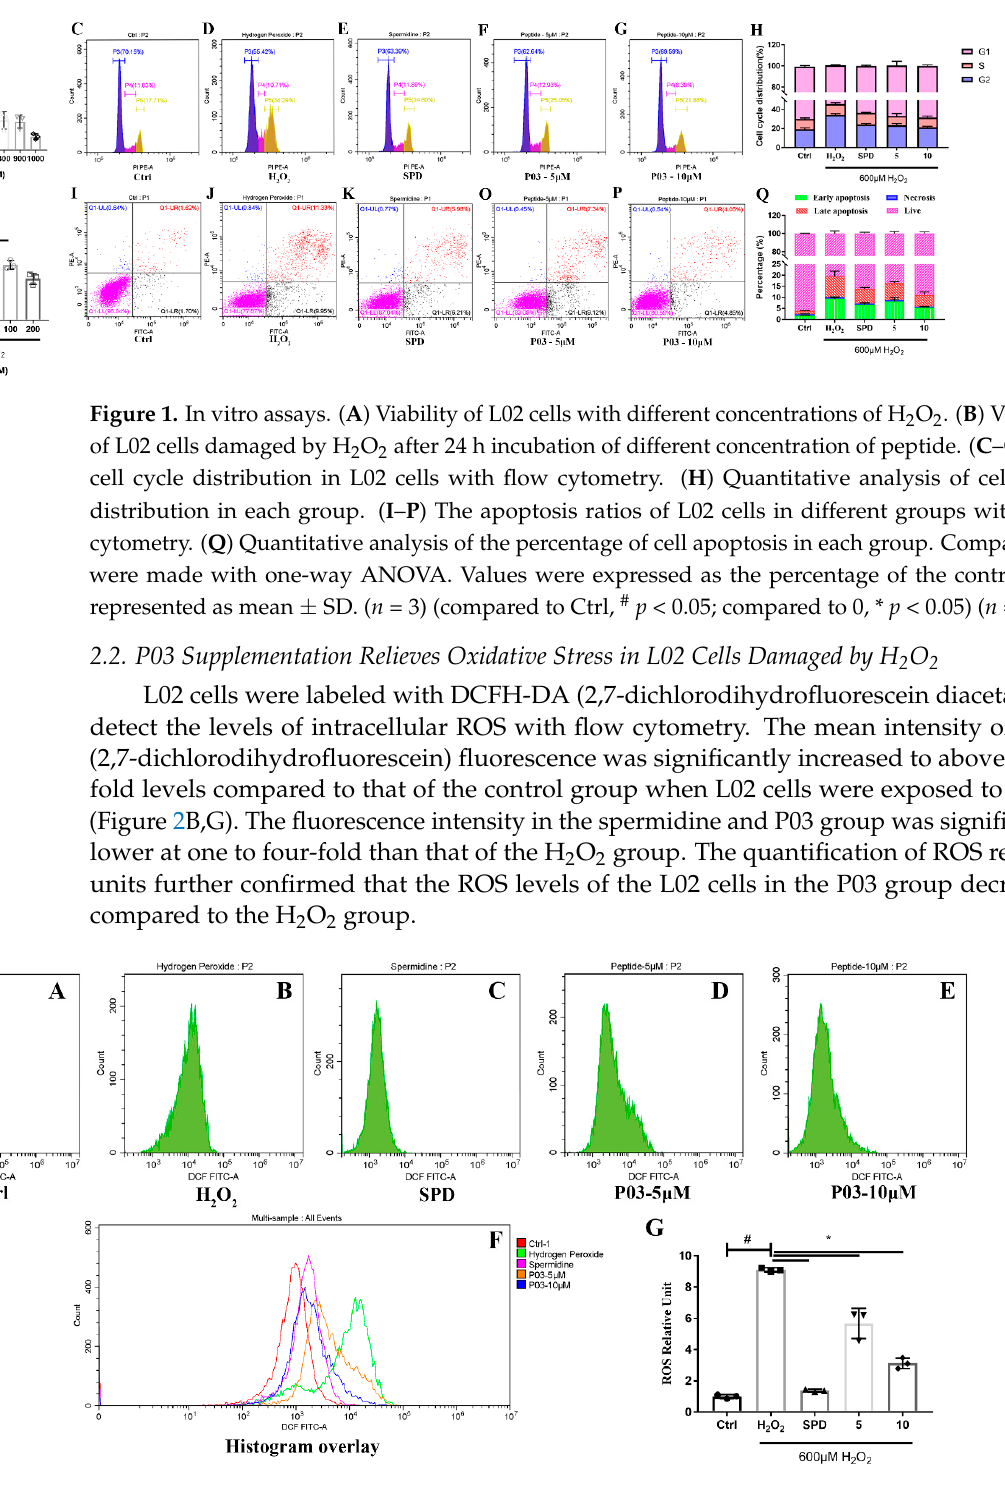
Figure 2. The ROS levels of L02 cells. ( A – E ) The mean DCF fluorescence intensity of L02 cells in different groups with flow cytometry. ( F ) Histogram overlay of each group. ( G ) Quantitative analysis of ROS relative units in each group. Comparisons were made with one-way ANOVA. Values were expressed as the ratio of the control and represented as mean ± SD ( n = 3) (compared to Ctrl, # p < 0.05; compared to H 2 O 2 , * p < 0.05) ( n = 3). The experimental process is revealed in Figure 3A. The hepatotoxicity of a xenobiotic agent, such as alcohol, is positively associated with the ratio of wet liver weight to body weight. In Figure 3B, there was no significant difference in the body weight between each group within 5 weeks. Organ coefficient is the ratio of organ weights and body weights. As shown in Figure 3C, the organ coefficients of the livers in the ethanol group were con- siderably higher than those of the control mice after the intragastrical administration of 50% ethanol. The organ coefficient was 1.20 ± 0.07 in the ethanol group. In contrast, the organ coefficient was reduced to 1.16 ± 0.02 in the spermidine group, 1.10 ± 0.06 in the 10 mg/kg P03 group, and 1.08 ± 0.09 in the 20 mg/kg P03 group, respectively.